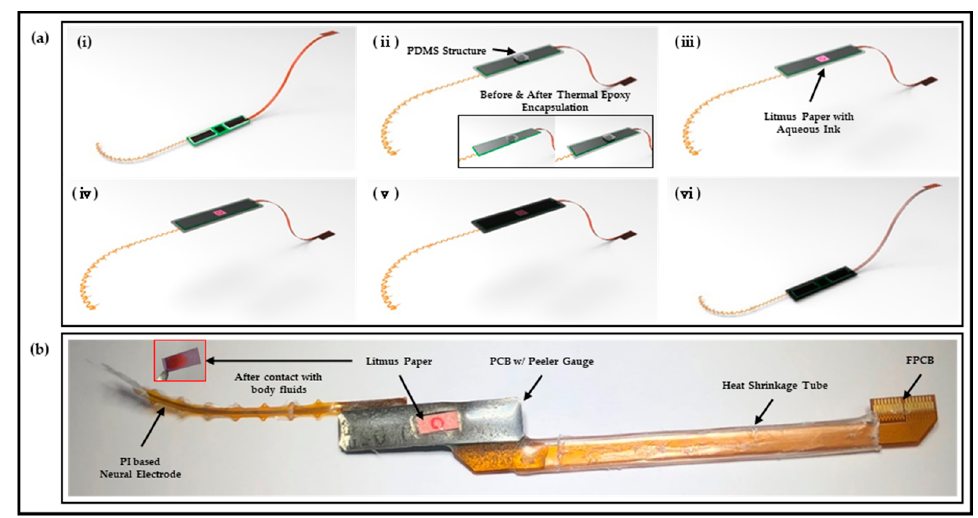
Figure 2. Packaging sample preparation. ( a ) Fabrication process of neural interface system with polymer-based packaging and ( b ) result of sample preparation.